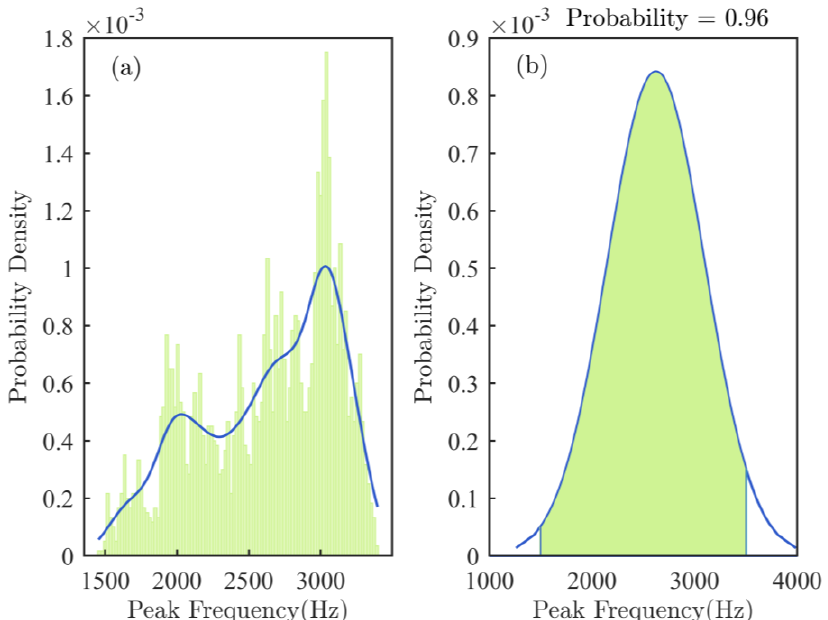
Figure 3. Probability density distribution of the gravel peak frequency 𝐺𝑓 𝑝𝑒𝑎𝑘 : ( a ) The vertical axis values of the histogram (green part) indicate the probability of the sample falling in each frequency interval, and the blue curve is the probability distribution fitting curve; ( b ) the probability value (shaded green area) calculated using autonomous programming.